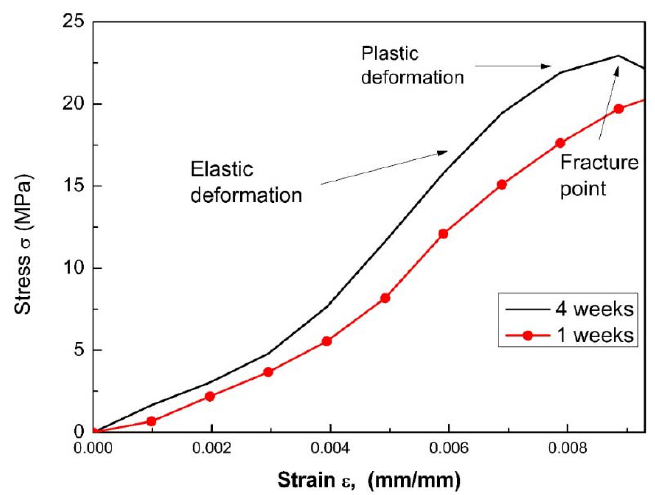
Figure 9. Compressive tests for cement cylinders with the dispersion for S2 and S3 .